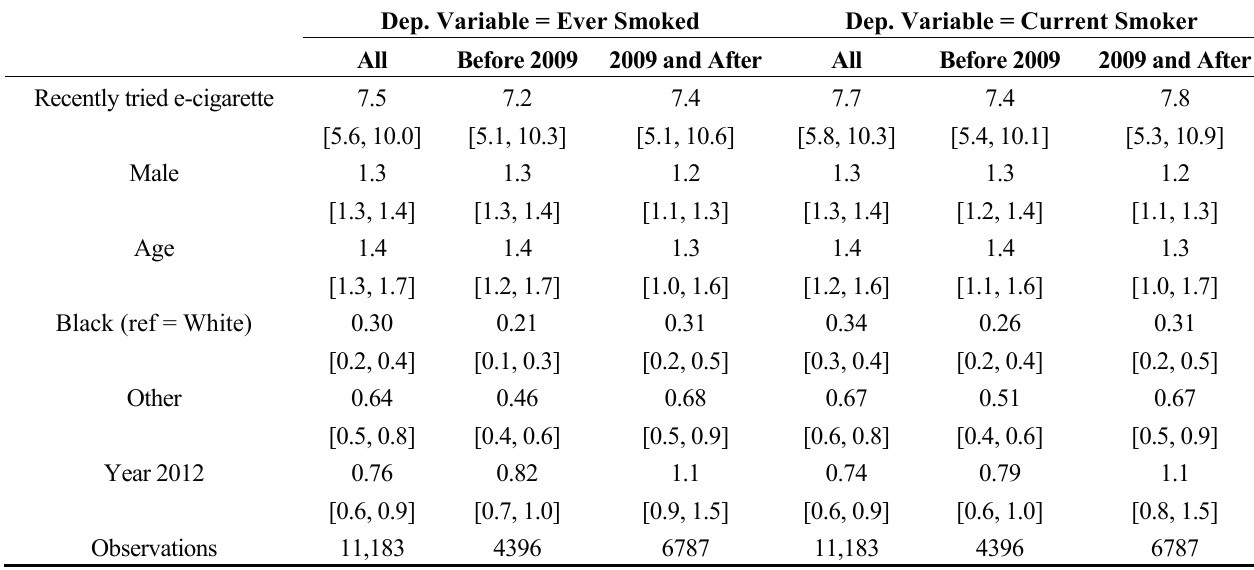
Table 7. Association of smoking and e-cigarette recent trying, by time of first trying a cigarette: before 2009 vs. later (ORs and 95%